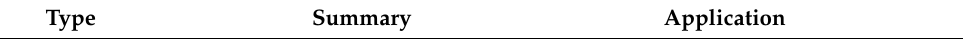
Table 1. Types of Alveolar Bone Regeneration